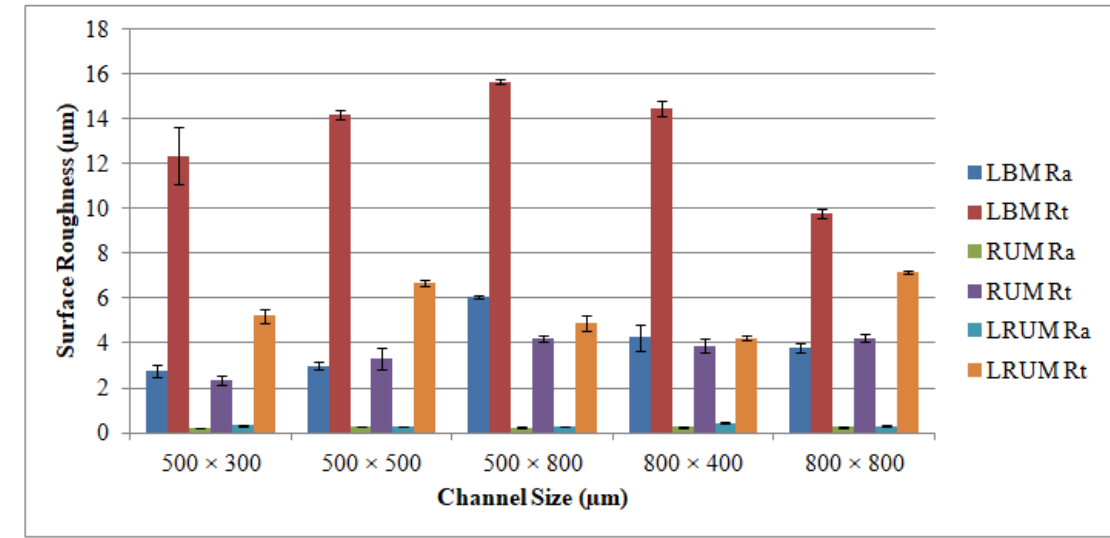
Figure 9. Results of surface roughness of the fabricated channels by using LBM, RUM, and combined LRUM processes.